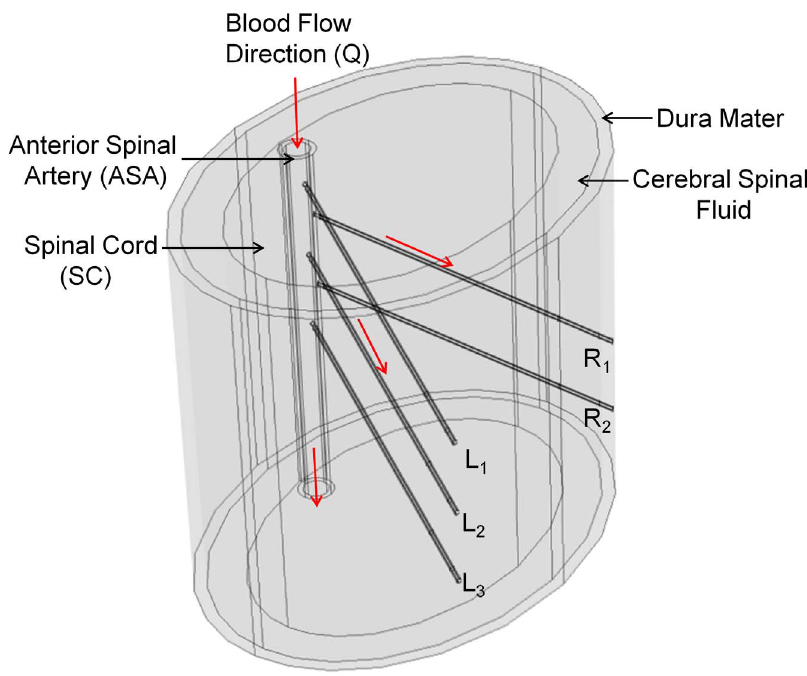
Figure 1. Schematic of simulation geometry comprising an ellipsoid segment of the cervical spinal cord surrounded by a cerebrospinal fluid (CSF) layer and dura mater. The anterior spinal artery (ASA) is within the spinal cord and has a luminal diameter of 1 mm and a thickness of 0.2 mm. Branches of the ASA are shown as L1, L2, L3, R1, and R2, all with luminal diameters of 0.14 mm and a thickness of 0.03 mm. Blood flow direction is indicated at the inlet of the ASA towards the ASA outlet and the 5 arterial branches, with a pressure gradient of